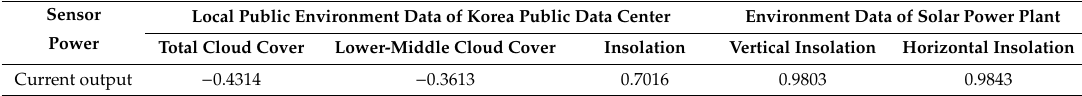
Table 1. Correlation coe ffi cient measurement table between power generation data and public data.